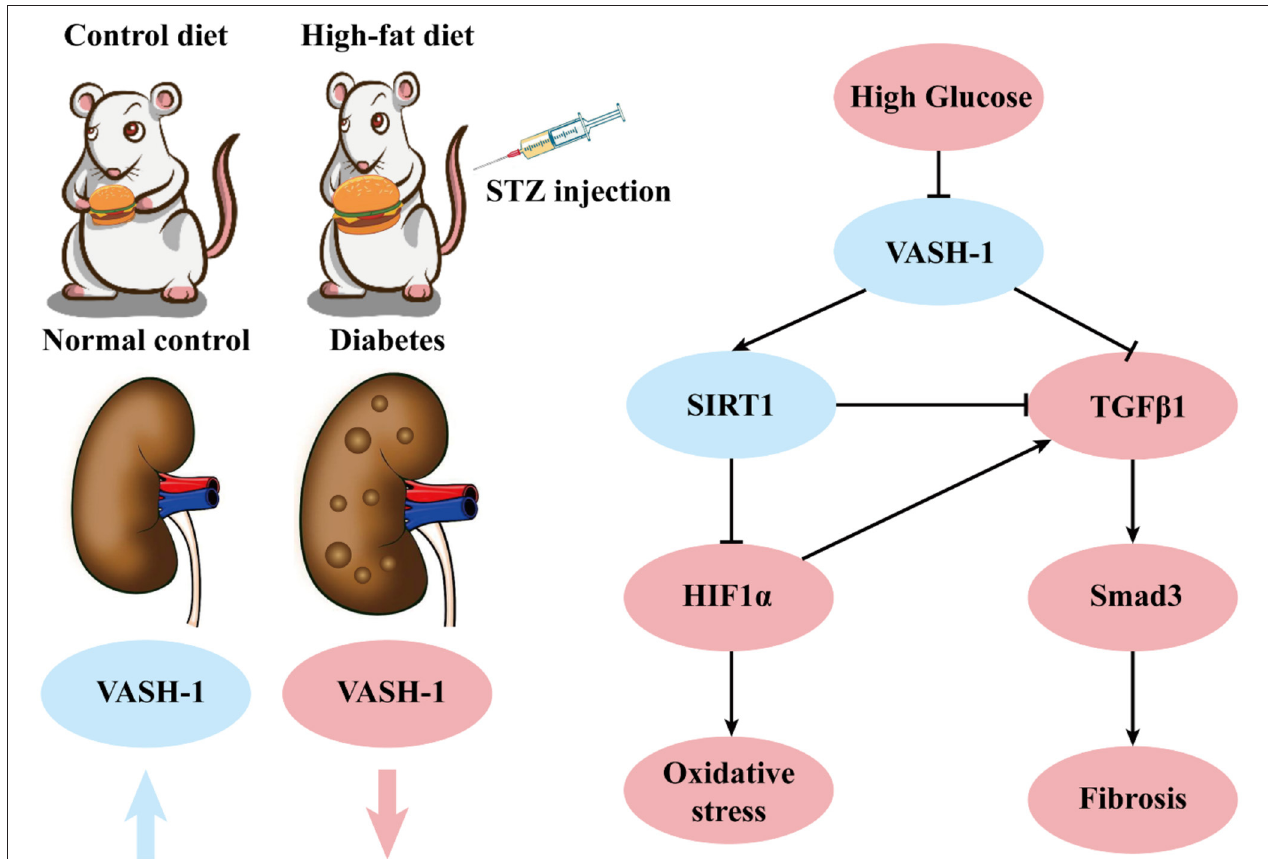
FIGURE 9 | Possible molecular